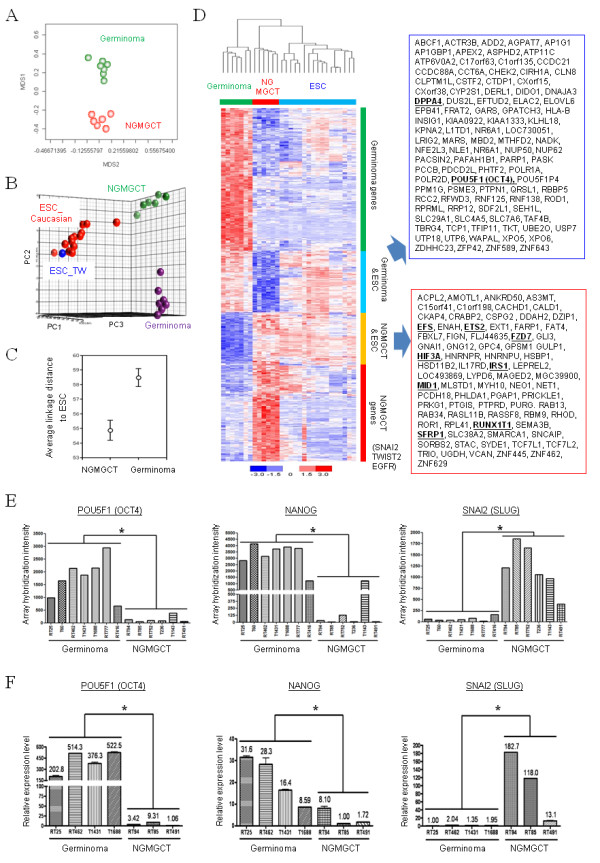
Gene expression analysis of the different GCT subgroups. (A) A multidimensional scaling (MDS) plot containing the differentially expressed genes (690 probe sets, q < 0.001). Each spot represents a single array. (B) A comparison of the transcriptome traits between ESCs and NGMGCTs by principal component analysis (PCA). (C) Relationships between ESCs, germinomas and NGMGCTs. Average linkage Euclidean distances between the tissues and ESC were calculated using genes distinguishing the filtrated 690-probe set. The confidence limits shown represent the standard error. (D) A heat map shows genes enriched in the ESCs and in the different prognostic groups (q < 0.001). (E-F) Real-time PCR validation of the microarray data. Mean expression levels of the examined genes were compared to that of the GAPDH control. Each bar represents a different individual (F). The genes' array hybridization signals are also shown (E).